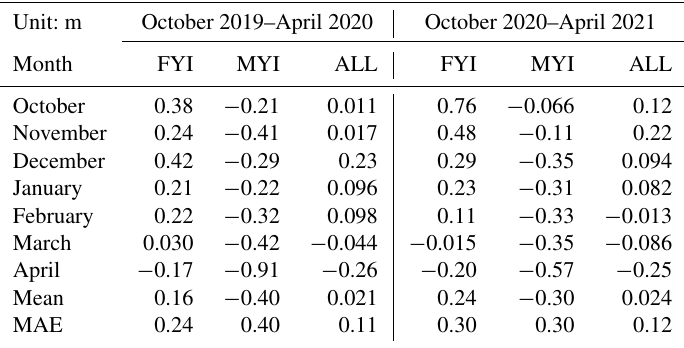
Table 6. Differences in the monthly mean sea ice thicknesses of HY-2B and CryoSat-2 on FYI, MYI and total sea ice. Unit: